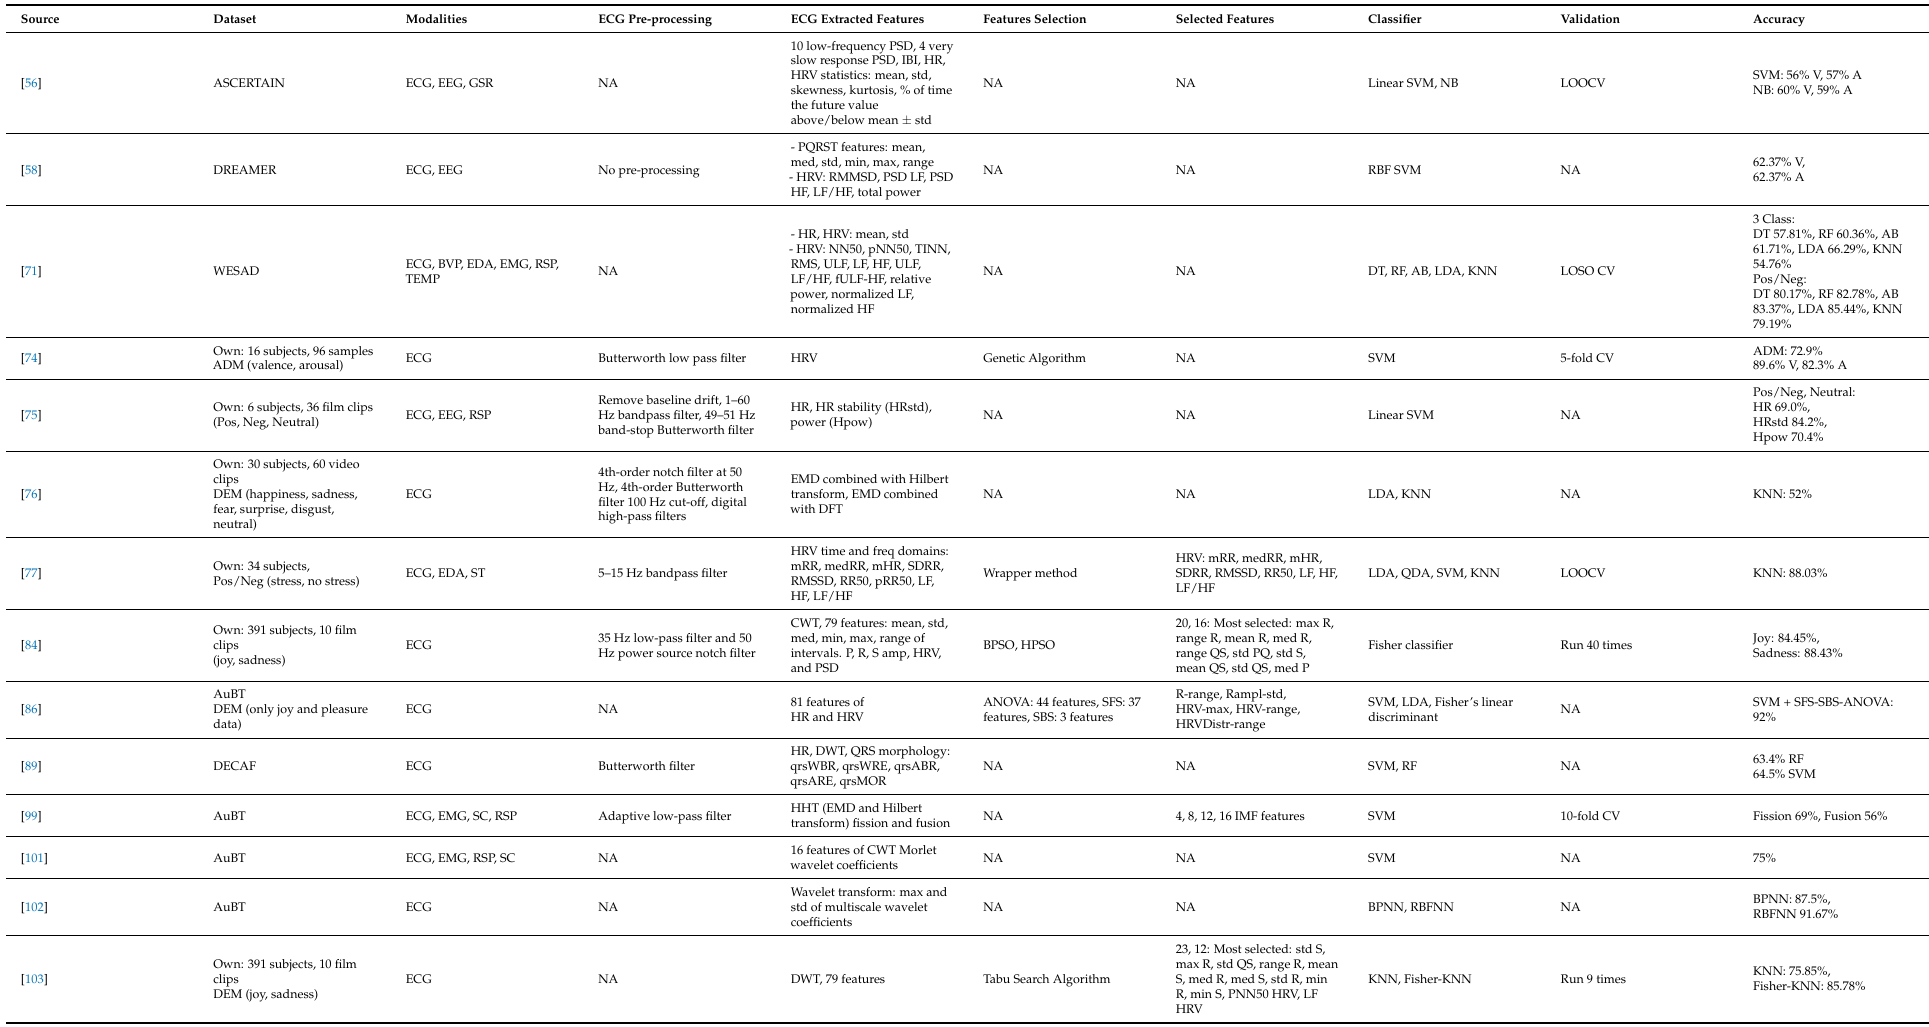
ECGPre-processing ECGExtractedFeatures FeaturesSelection